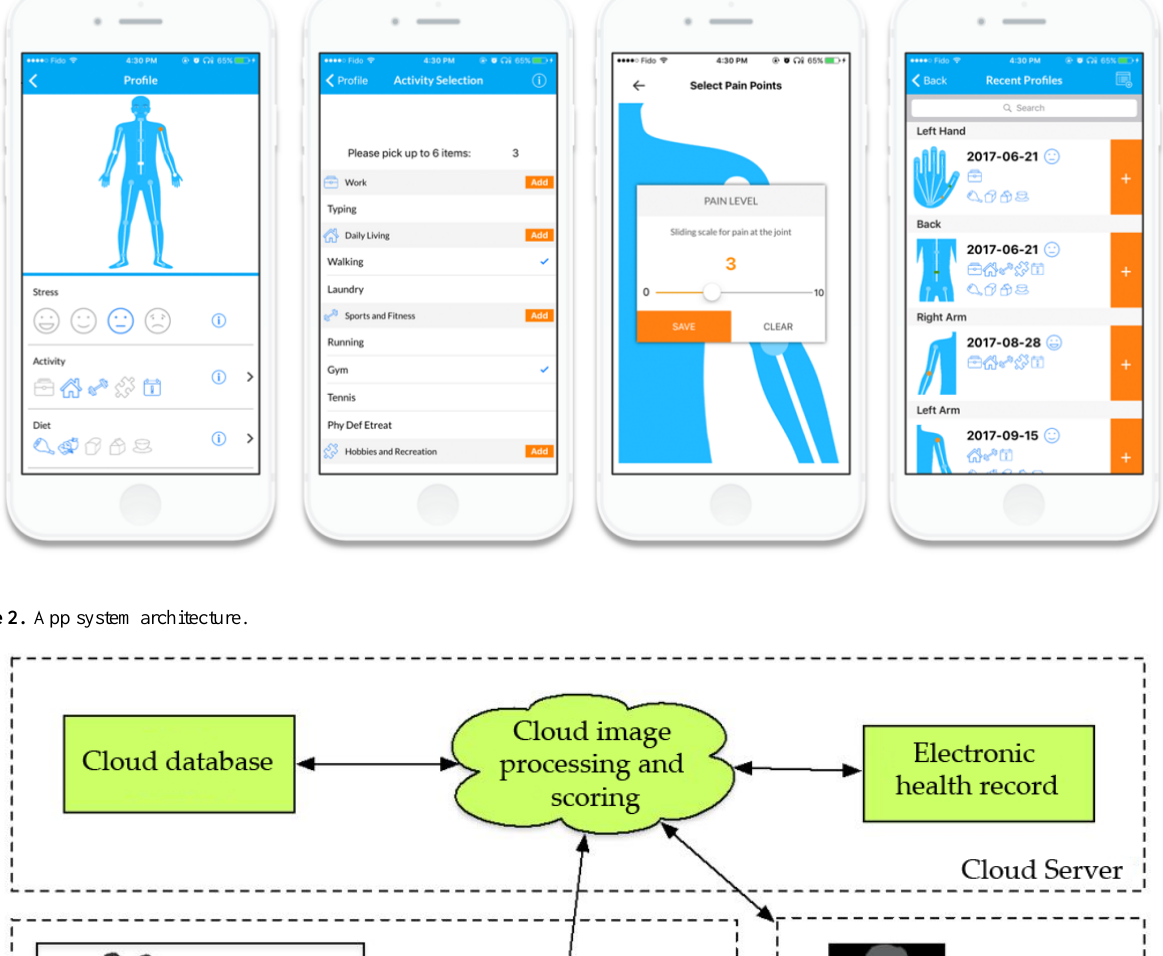
Figure 1. App self-management features.